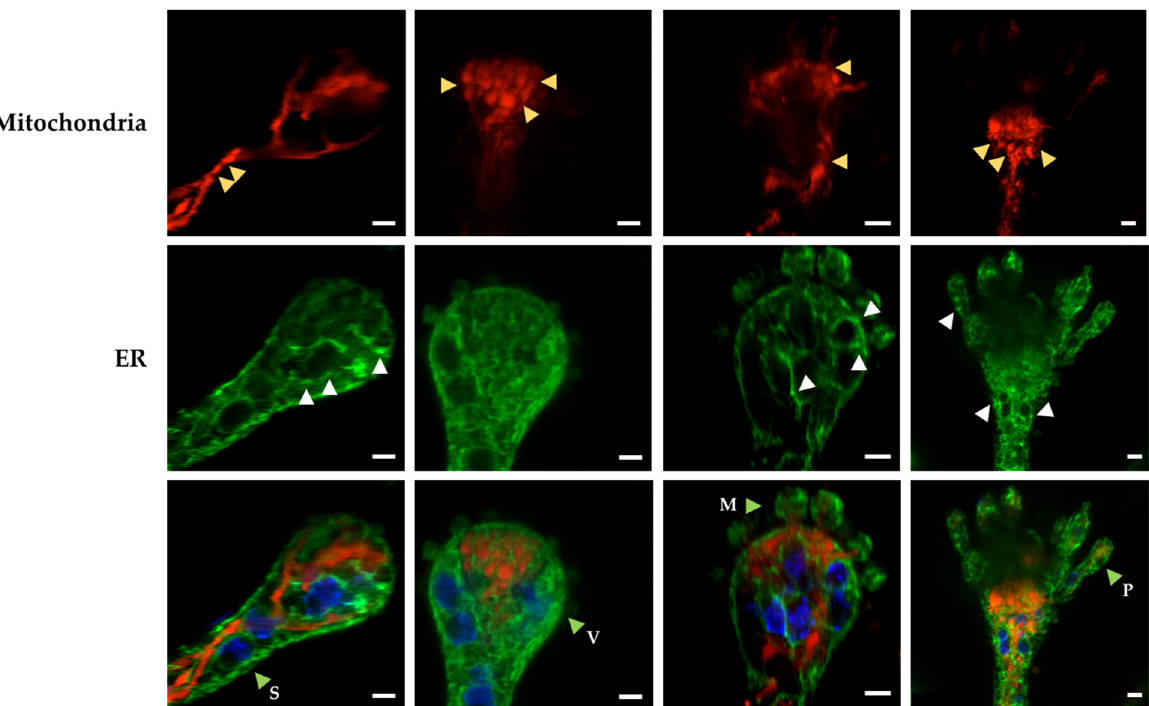
Figure 7. Mitochondrial constrictions and ER-dotted structures are produced during normal conidiophore development. The growing edge of an Δ dnmA (CVG47) colony grown for 3 days was sectioned, and its conidiophores were observed using Airyscan microscopy. The red, green and blue signals correspond to mitochondria labelled with mCherry, ER labelled with GFP, and nuclei labelled with BFP, respectively. The yellow arrowheads point to constricted mitochondria; white arrowheads indicate ER-dotted structures. The green arrowheads point to conidiophore stalks (S), vesicles (V), metulae (M) and phialides (P). Scale Bar = 2 µm.